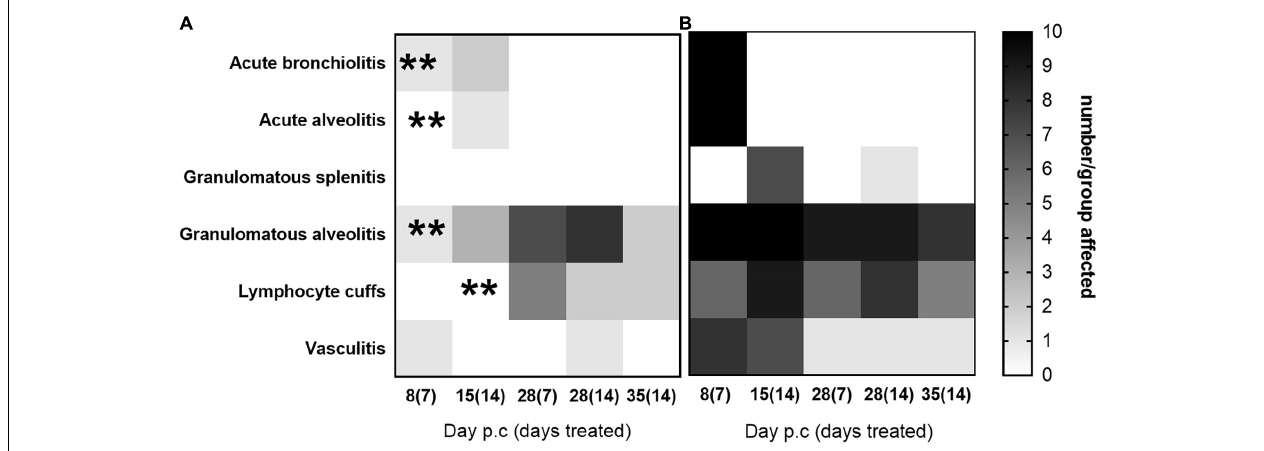
FIGURE 7 | The occurrence of typical histopathological features associated with C. burnetii in lung and spleen tissues. At 24 h post-challenge mice were treated with (A) finafloxacin (30 mg/kg) or (B) the carrier, once a day orally for 7 or 14 days. Tissues were harvested on days 8, 15, 28, and 35 p.c. and scored for the presence/absence of 6 typical histopathological features associated with murine Q fever and displayed as a heat map (where white is no animal affected and black is all 10 affected). ** p <